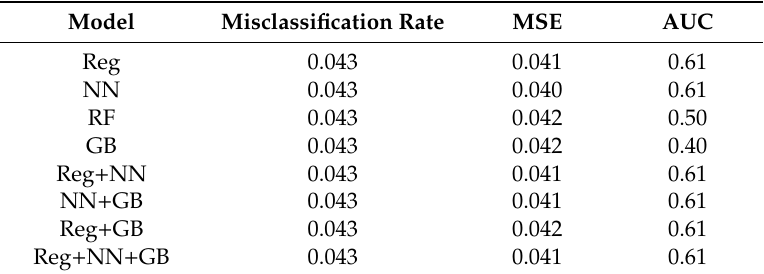
Table 17. Model comparison.